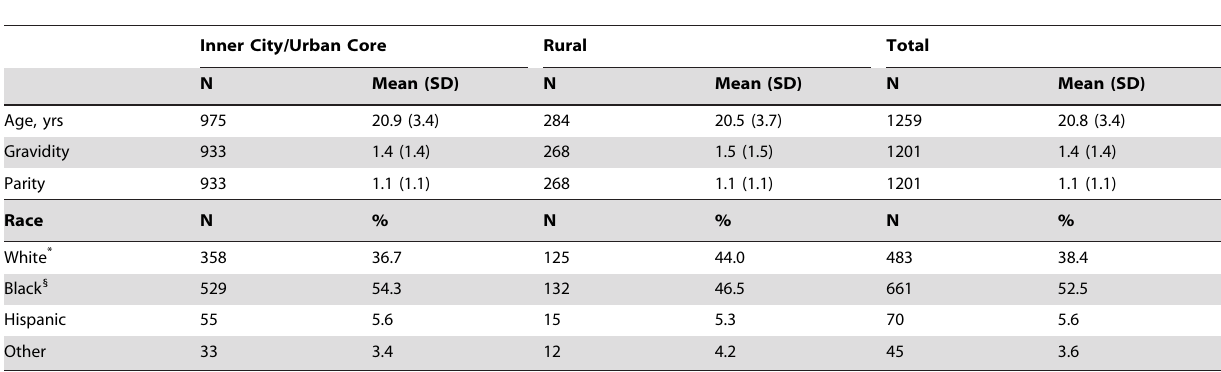
Table 1. Descriptors of females receiving care at the Inner City/Urban Core vs. Rural Safety Net Health Care Locations.